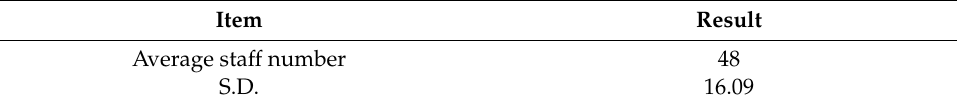
Table 4. How many people make up the staff? Item